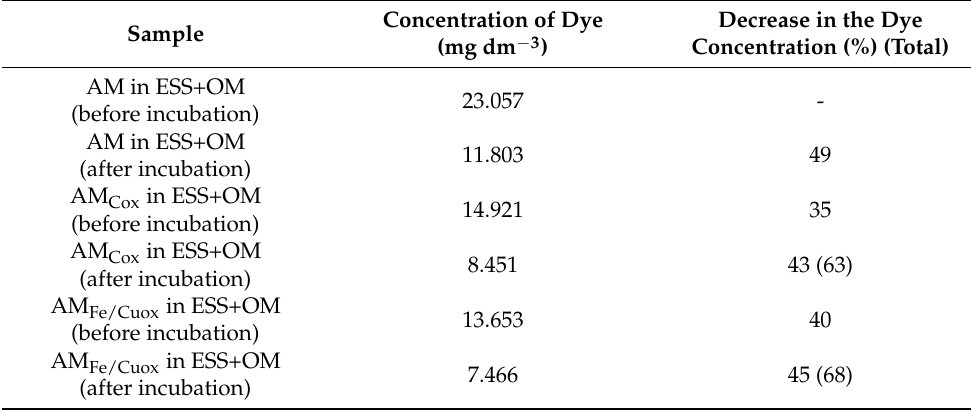
Table 5. Quantitative dye assay was recorded for a wavelength of 500